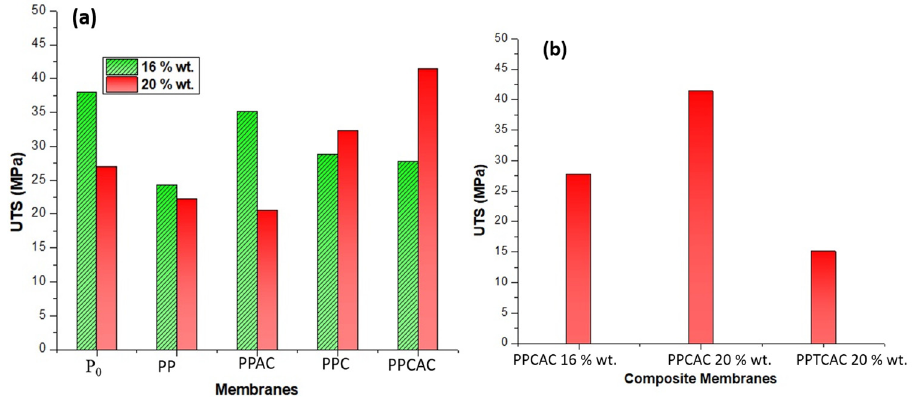
Figure 9. Ultimate Tensile Strength for ( a ) 16 and 20% PES membranes, and ( b ) composite mem- branes.